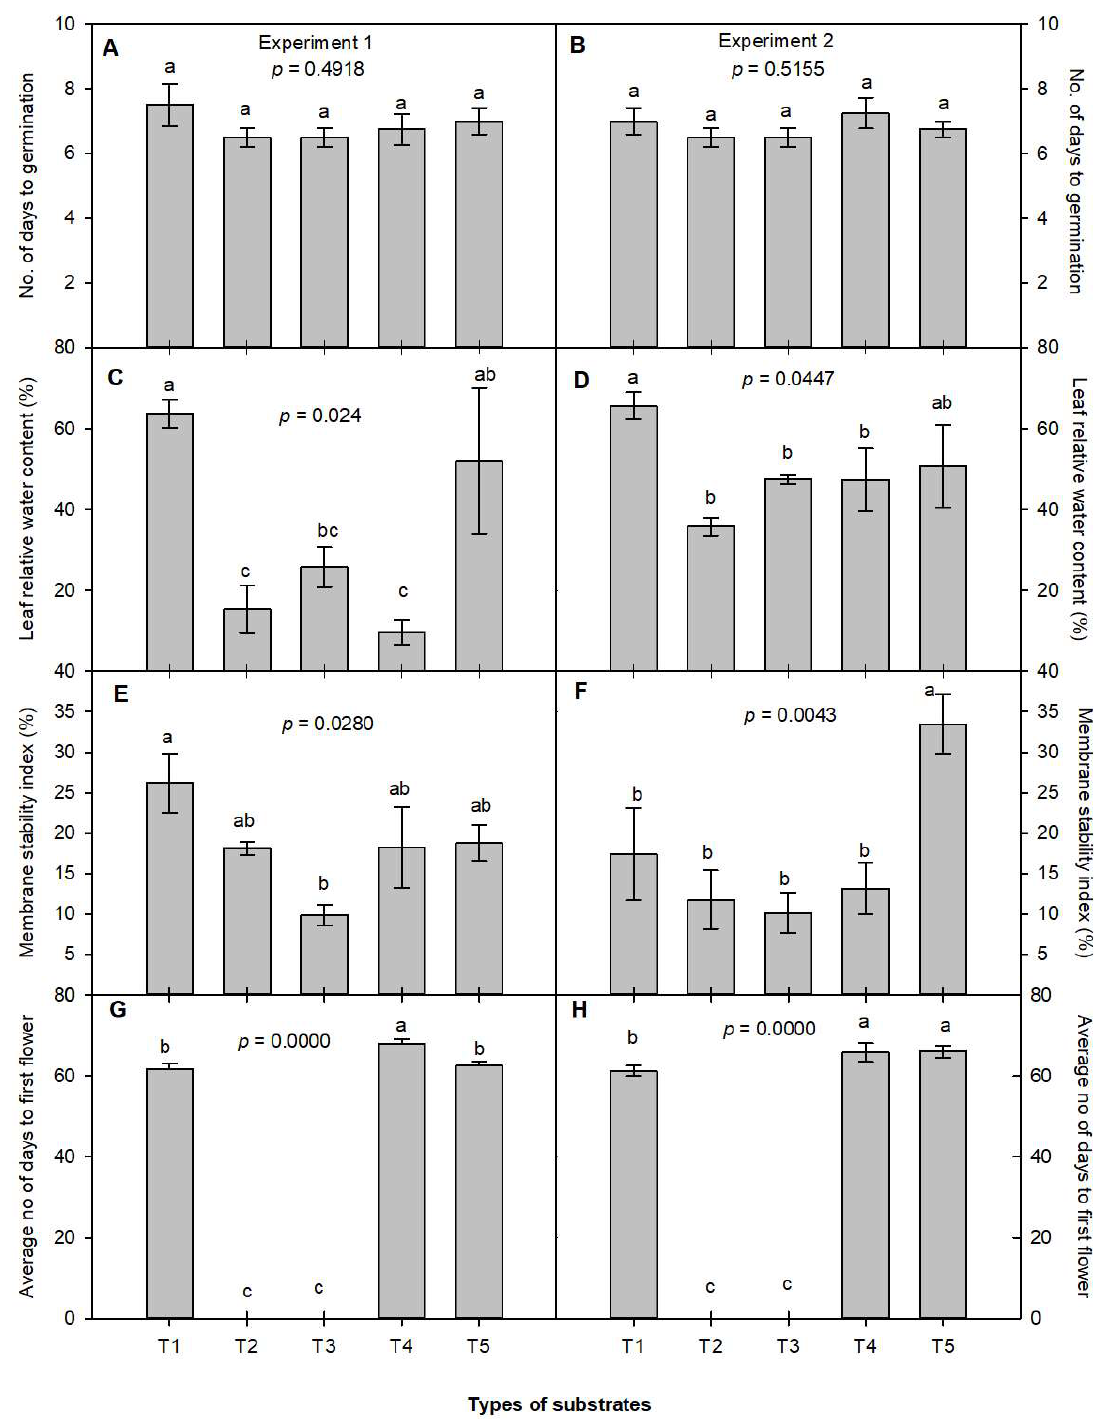
Figure 4. Effect of non-composted Bombax ceiba (Red cotton tree) sawdust mixtures on Abelmoschus esculentus L. (okra). Seed germination ( A , B ), leaf relative water content ( C , D ), membrane stability index ( E , F ), and an average number of days taken to first flowering ( G , H ) in two independent experiments. All treatments (T 1 , T 2 , T 3 , T 4 , T 5 ) were the same as described in Figure 1. Different letters display significant differences between treatment mean values at the top of the vertical bars, as determined by the least significant difference test (LSD) at p < 0.05. Differences between treatments were very significant, as evidenced by the p = 0.0000. The error bars show the standard error ( n = 4). There was no flowering in T 2 and T 3 before